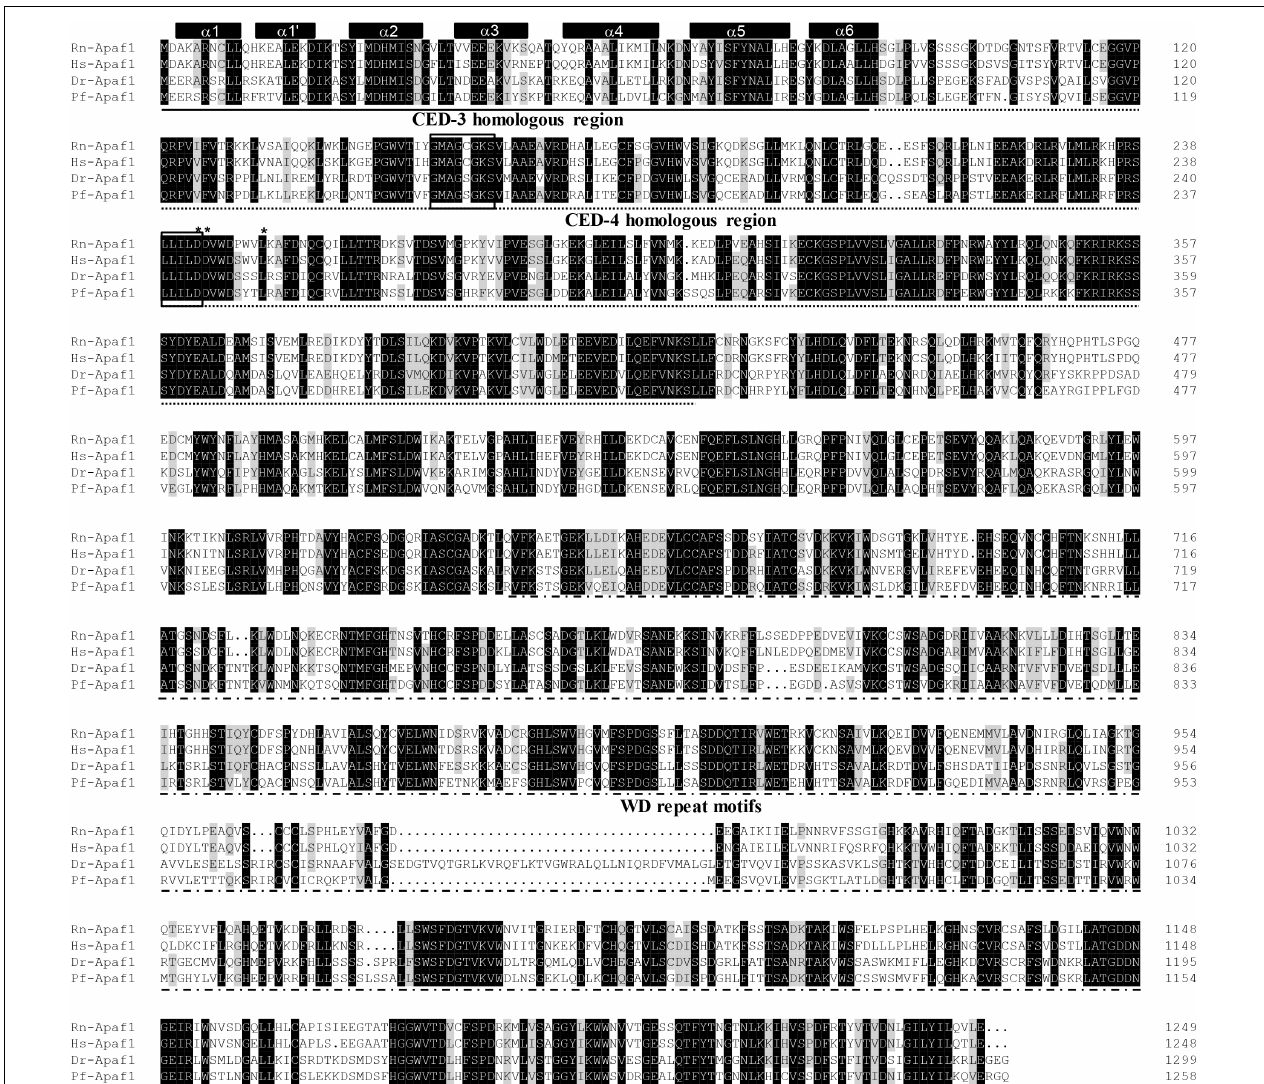
FIGURE 2 | Multiple amino acid sequence alignment of Apaf1 genes from P. fulvidraco and other species. Accession numbers were ENSRNOP00000041521, ENSP00000448165, NM_131608.1, KY053839 for Rattus norvegicus (Rn), Homo sapiens (Hs), Danio rerio (Dr), and Pelteobagrus fulvidraco (Pf), respectively. The CED-3 and CED-4 homologous region and WD repeat motifs indicate in a continuous and discontinuous line. Apaf1 CARD (caspase recruitment domain) contains seven short α -helices which are represented by cylinders on top of the sequence alignment. The Walker’s A- and B-box consensus sequences for nucleotide binding sites at amino acid residues 153–160 and 238–242 are boxed. Asterisks denote the amino acid residues that are known to be important for CED-4 function. Deep and light shadows represent homology of 100 and 75%, respectively.